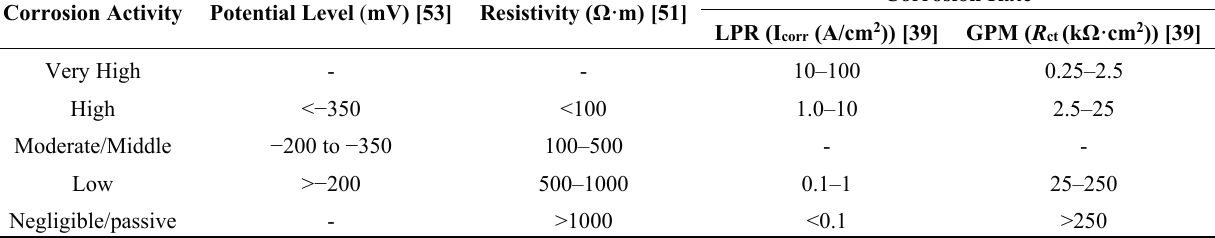
Table 1. Interpretation of corrosion activity of electrochemical